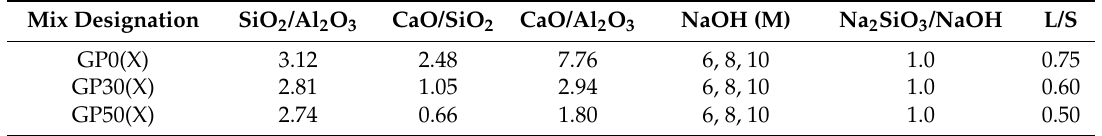
Table 1. Bulk composition and batch mixing of Geopolymer